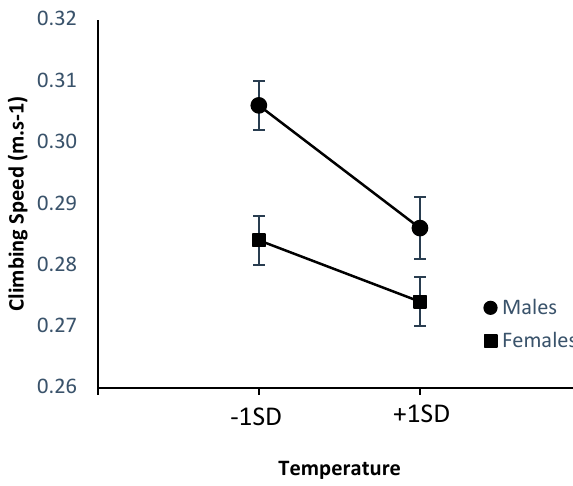
Figure 4. Effects of temperature on climbing speed (m · s − 1 ).